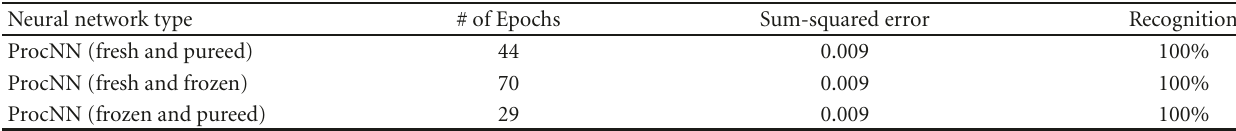
Figure 5: Reduced image size (600 × 900 pixel) for (a) fresh, (b) pureed, and (c) frozen sweet red peppers. Table 1: Training statistics for